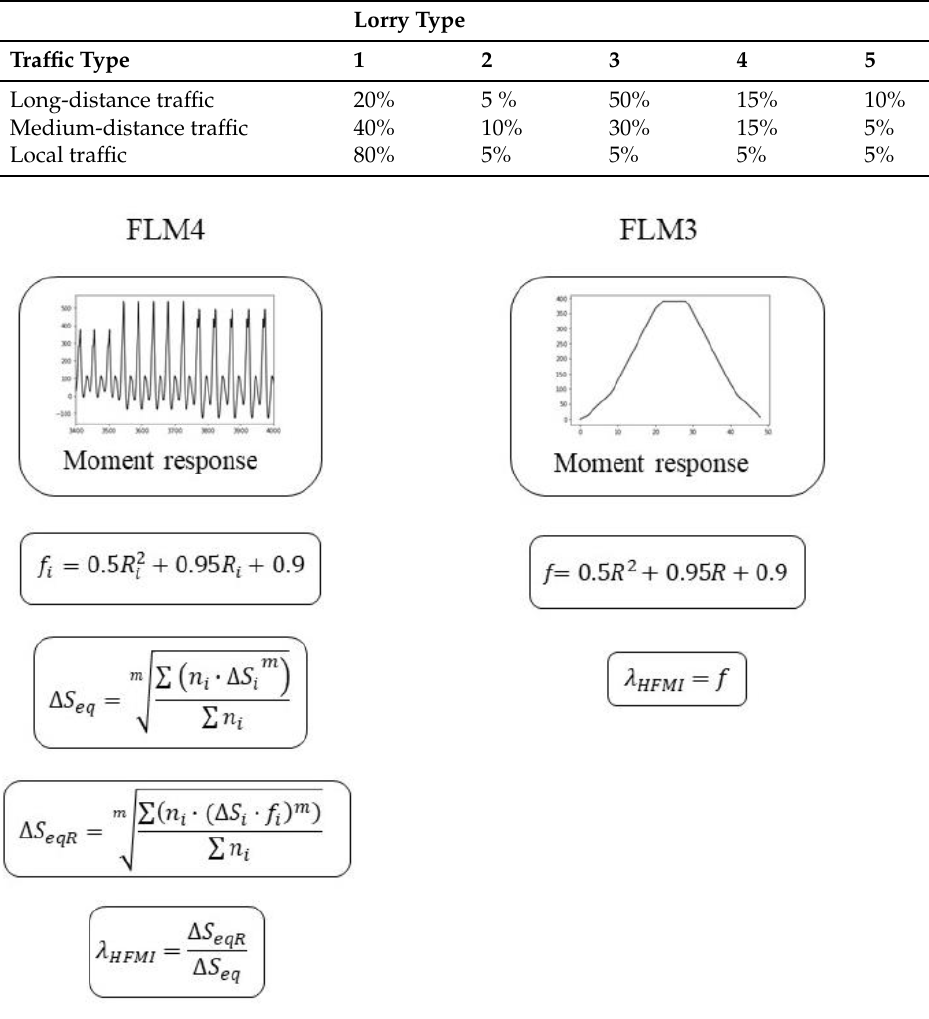
Figure 10. λ HFMIFLM 3 and λ HFMIFLM 4 calculation